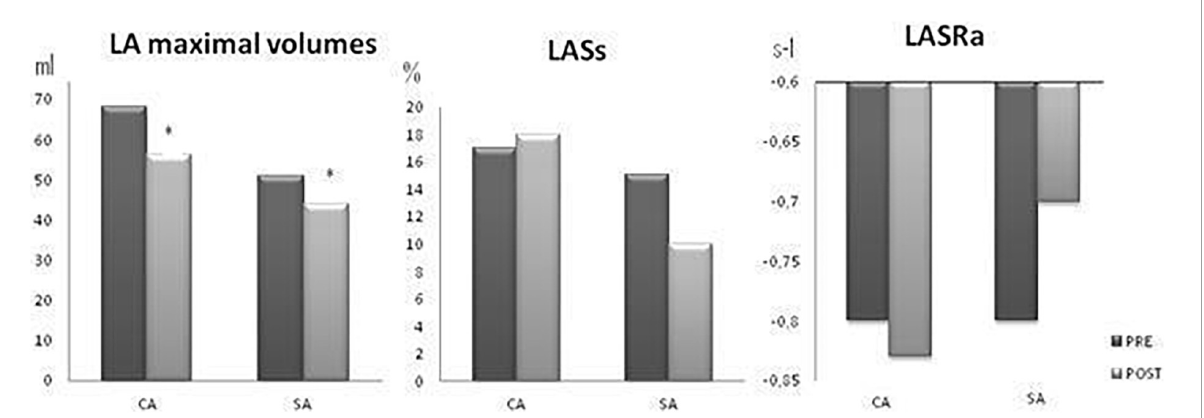
FIGURE2 Effect of catheter (CA) and surgical ablation (SA) on LA size (LA 2D maximum volume) and LA reservoir (LASs l ) and LA booster function (LASRa l ). PRE, pre-ablation (black bars) and POST, post-ablation (gray bars). CA, Catheter ablation; SA, surgical ablation. * p < 0.05 POST vs. PRE.